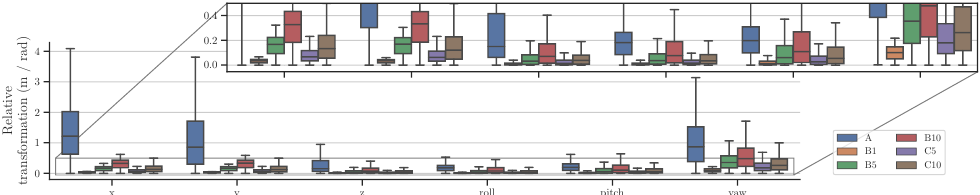
Figure 4. Median and quartiles of the absolute components of the resulting relative transformations when using the studied reference frame selection methods on the noiseless base trajectories of the simulation